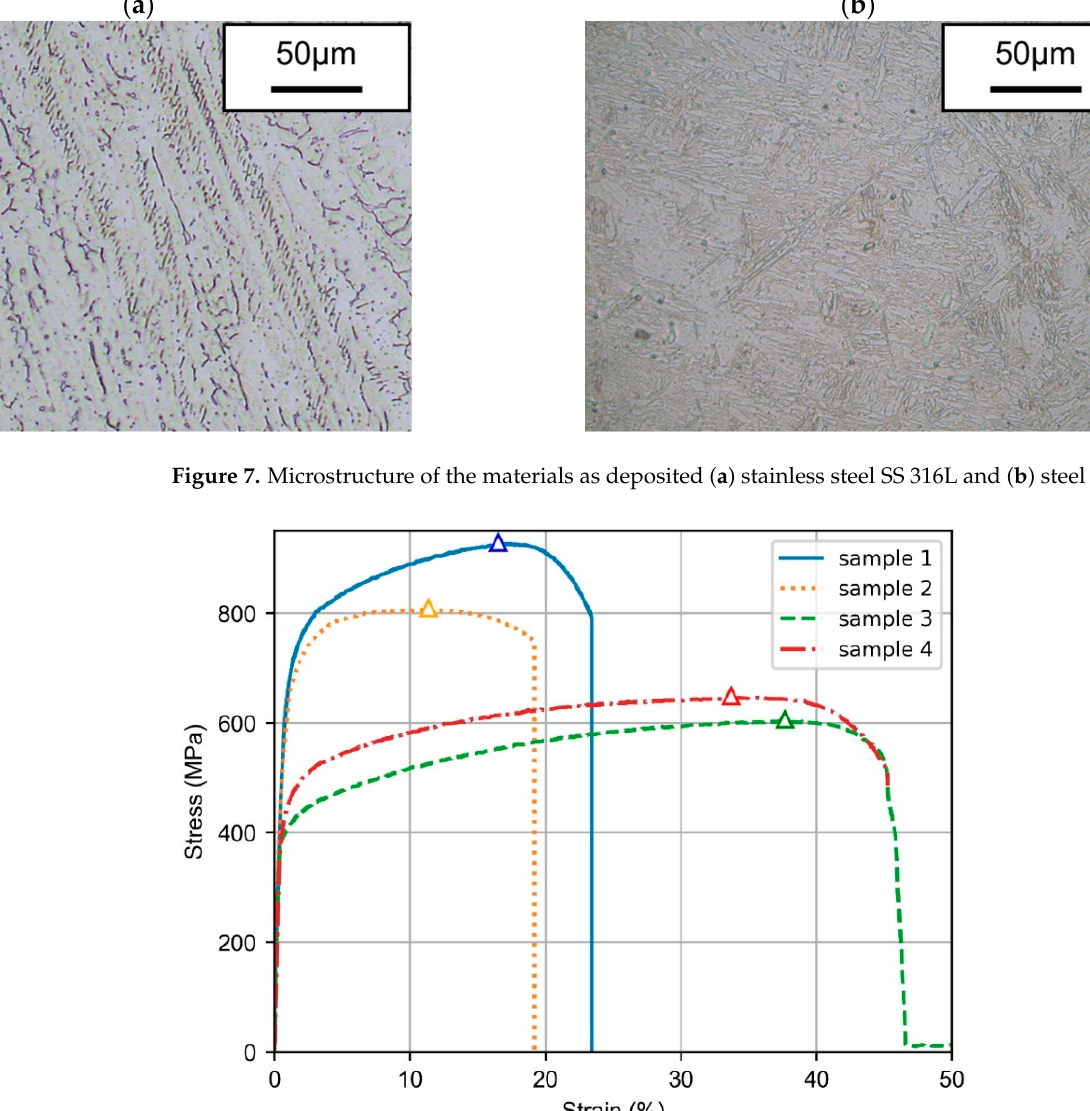
Figure 8. Results of the stress–strain curve for the specimens extracted from the manufactured walls, the triangles show the UTS for each test.